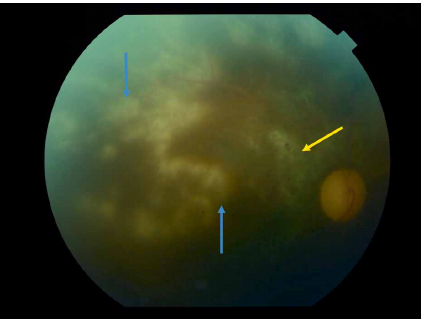
Figure 1: Fundus photograph with a yellow arrow marking an old, atrophic choroidal scar and blue lines delineating multiple white/off- yellow exudates around the macular and extending into the peripheral retina. Pallor of the optic disc is notable as well as minor vitreous haze.